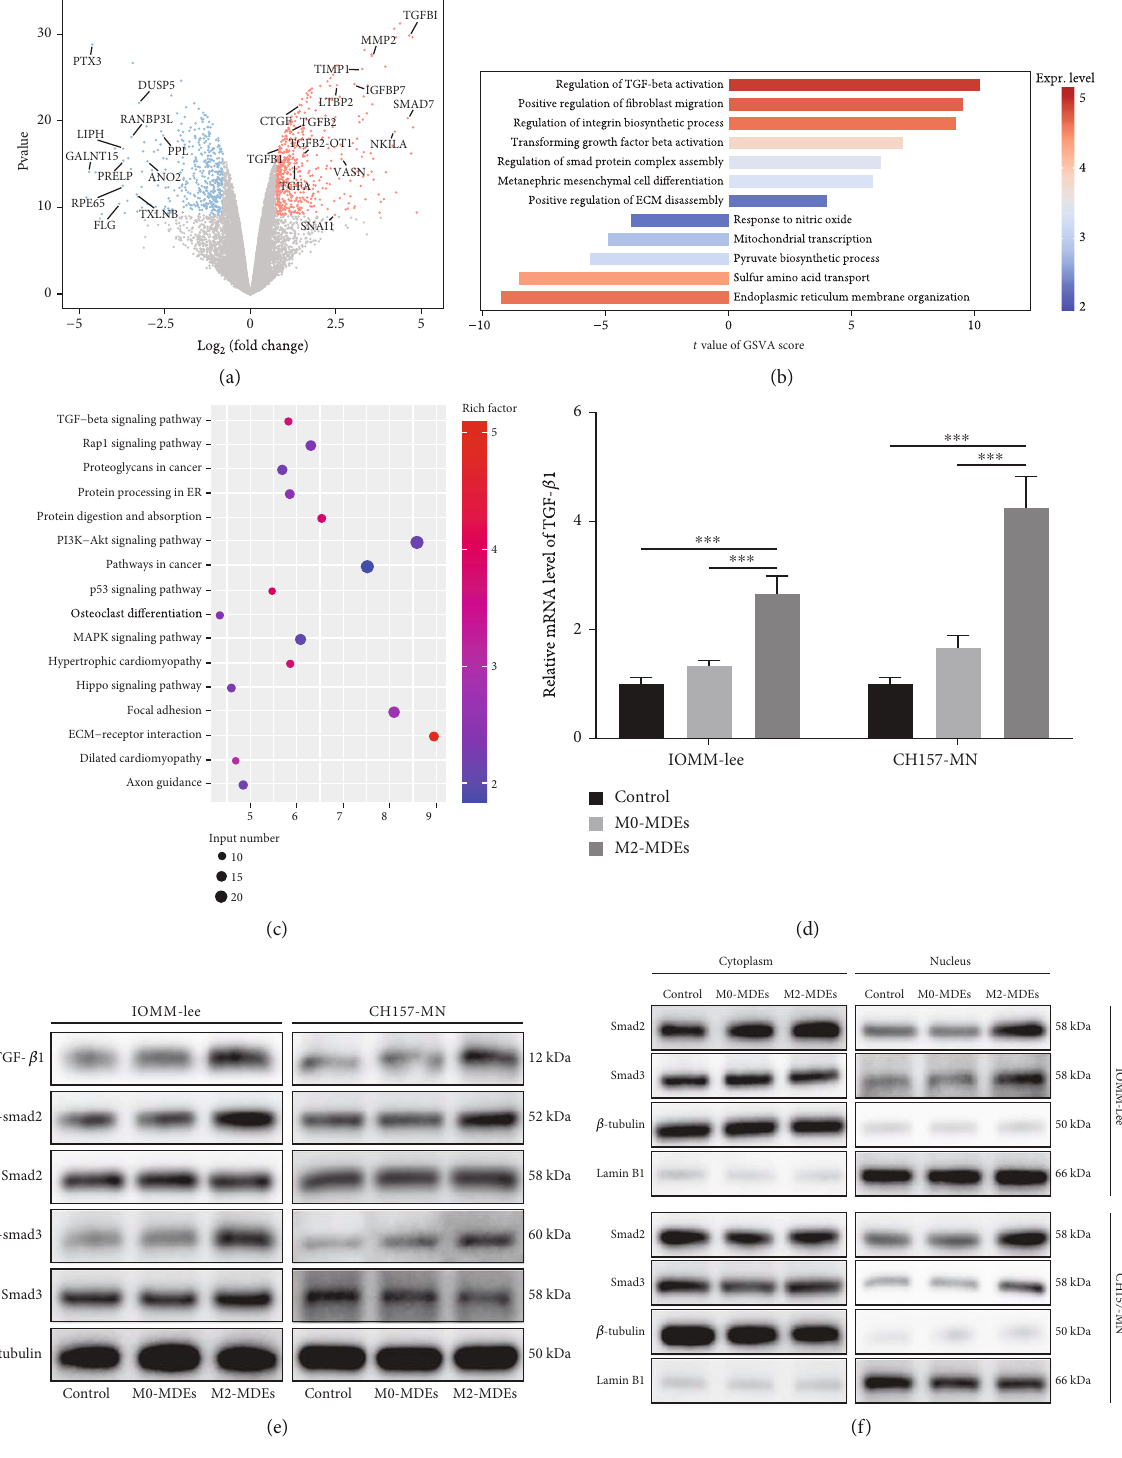
Figure 4: The TGF- β pathway is activated in M2-MDE-treated meningioma cells. (a) Volcano plot showing di ff erentially expressed genes in IOMM-Lee cells cocultured with M2-MDEs relative to M0-MDEs. (b) GO enrichment analysis was used to reveal the functional characteristics of IOMM-Lee after coculture with MDEs according to the MSigDB database. (c) KEGG pathway analysis of IOMM-Lee after coculture with MDEs based on di ff erentially expressed genes0. (d) qPCR was used to detect the mRNA expression level of TGF- β 1 in meningioma cells. (e) Western blotting was used to detect the protein expression levels of TGF- β 1, Smad2, p-Smad2, Smad3, and p- Smad3 in meningioma cells. (f) Western blotting for the expressions of Smad2 and Smad3 in the cytoplasm and nucleus of meningioma, respectively. β -Tubulin and lamin B1 serve as house-keeping genes for cytoplasmic and nuclear proteins, respectively. ∗ p < 0 : 05 , ∗∗ p < 0 : 01 , ∗∗∗ p < 0 : 001 , vs. the control and M0-MDE